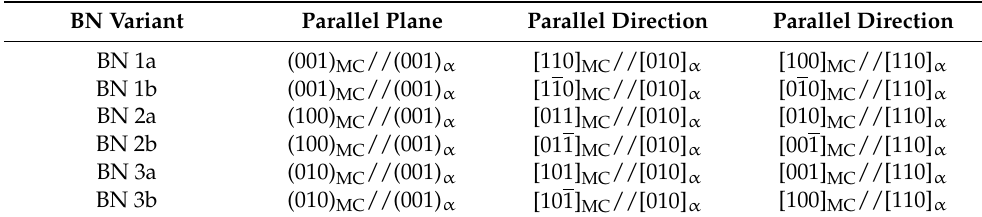
Figure 3. Illustration of OR between MC precipitates and ferrite matrix under BN 1a ( a ) and corre- sponding stereographic projection ( b ). Table 2. Three variants of BN ORs between carbide and ferrite.